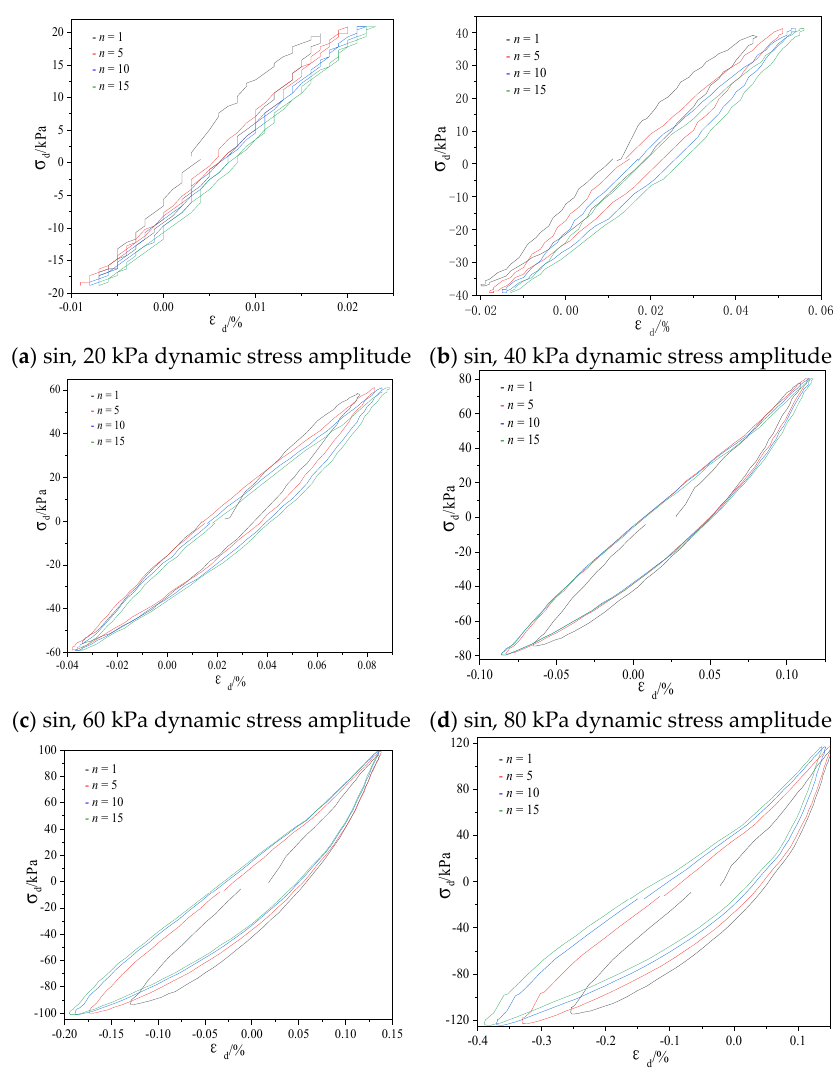
Figure 12. Characteristic analysis of hysteretic curve under different cycle times. It can be seen that the number of cycles has little effect on the hysteretic curve at a low dynamic stress amplitude. The hysteresis curve is narrow. Under different cycle times, each hysteretic curve basically coincided. The amplitude of the strain, the area sur- rounded by the hysteresis curve and the slope performed little changes. When the dy- namic stress amplitude reached 120 kPa, the hysteretic curve began to deviate greatly with the increase in cyclic loading times. In the case of a small dynamic stress amplitude, within a certain number of cycles, the hysteretic curve of the coarse-grained soil specimen was less affected by the number of cycles. In the case of a large dynamic stress amplitude, the hysteretic curve of the coarse-grained soil specimen was greatly affected by the number